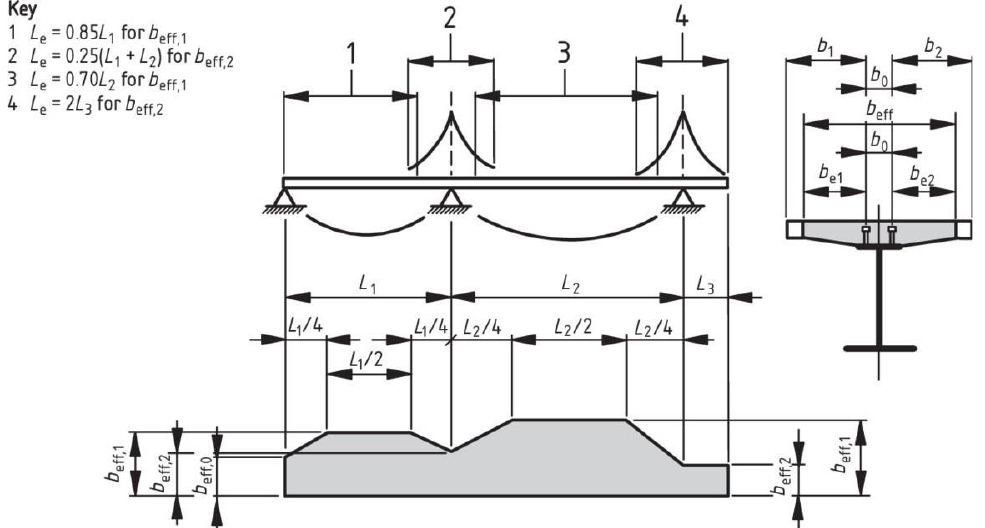
Figure 4. Equivalent spans for the effective width of the concrete flange in EN 1994-1-1 [12]. In EN 1994-1-1, the maximum value of the effective width b e1 = b e2 = span/8 is on each side of the beam (see Figure 4). As well as considering this limit, the width assumed in the design must not exceed the actual slab width available, which is particularly relevant to edge beams and beams adjacent to openings. The rules of EN 1994-1-1 are more generous when the slab spans parallel to the span of the beam. 3.2. AS/NZS 2327:2017 As previously stated, EN 1994-1-1 has a significant impact on the design specifica- tions of Australia and New Zealand. Still, AS/NZS 2327:2017 [13] has made greater pro- gress towards perfection than EN 1994-1-1 because, in AS/NZS 2327:2017 clause 3.4.2, pro- visions of the effective width of concrete flange have three parts according to the type of slab. The first part is clause 3.4.2.1 for the solid slab, the second part is clause 3.4.2.2 for the composite slab, and the third part is clause 3.4.2.3 for the void slab. In clause 3.4.2.1, for the solid slab, the provisions of effective width are the same as in EN 1994-1-1 and use the same diagram as in Figure 4 to clarify the equivalent width. Still, it has a unique re- quirement — when a slab has pockets or a cut-out within its effective width, then, at the cross-section of concern, the effective width shall be reduced by the width they encroach into this region. In clause 3.4.2.2, for a composite slab in which the ribs are parallel to or